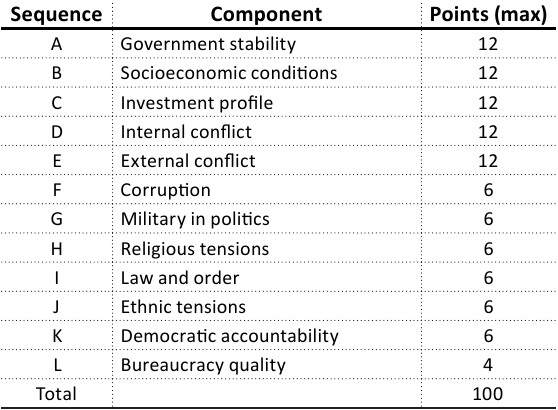
Table 2. Political risk components